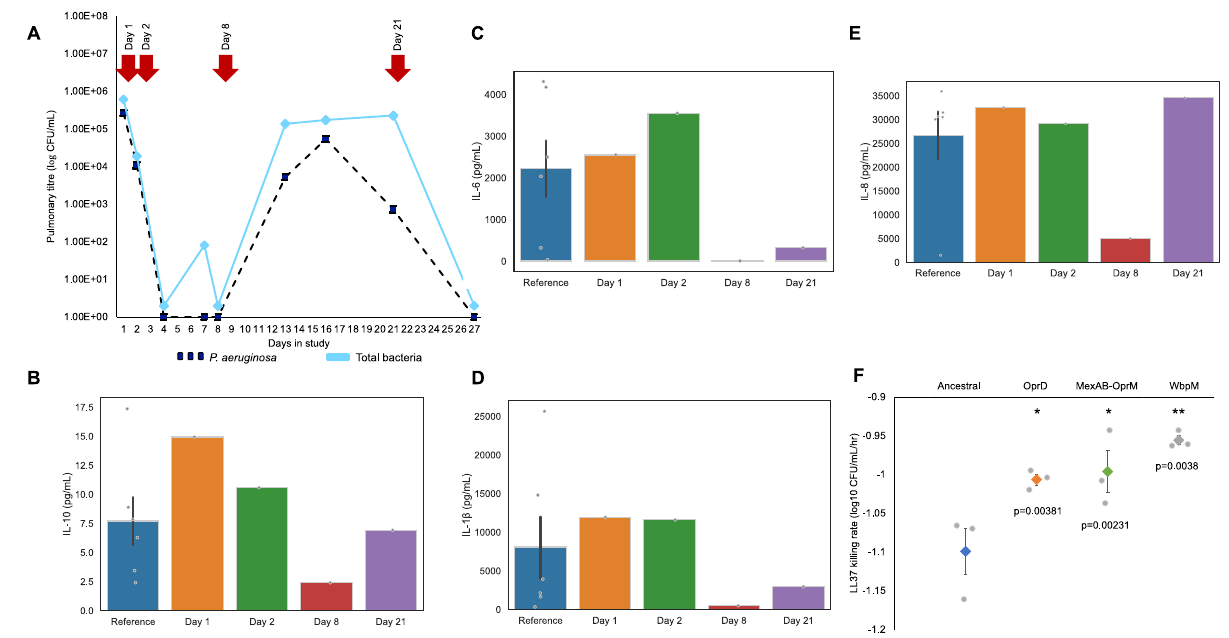
Fig. 5 Immune responses to infection. Cytokine concentrations were measured in samples of ETA collected over the course of infection. Panel A places cytokine sampling points into the context of the infection. Panels B – E show levels of cytokines that have been shown to protect against P. aeruginosa infection. A single measure of cytokine abundance was taken from each ETA sample due to the high reproducibility of these assays. Reference shows the abundance of cytokines in critically ill patients from the ASPIRE-ICU study who did not develop pneumonia (mean + / − s.e.m; n = 6 patients). F LL-37 tolerance of lung isolates, as measured by the rate of cell death at a fi xed dose of LL-37 (50 μ g/mL). Plotted points show death rate of each genotype (mean + / − s.e.m; n = 3 isolates). Increased LL-37 tolerance was only found in all mutants, as determined by a two-tailed Dunnett ’ s test treating the ancestral strain as a control group. Source data are provided as a Source Data fi